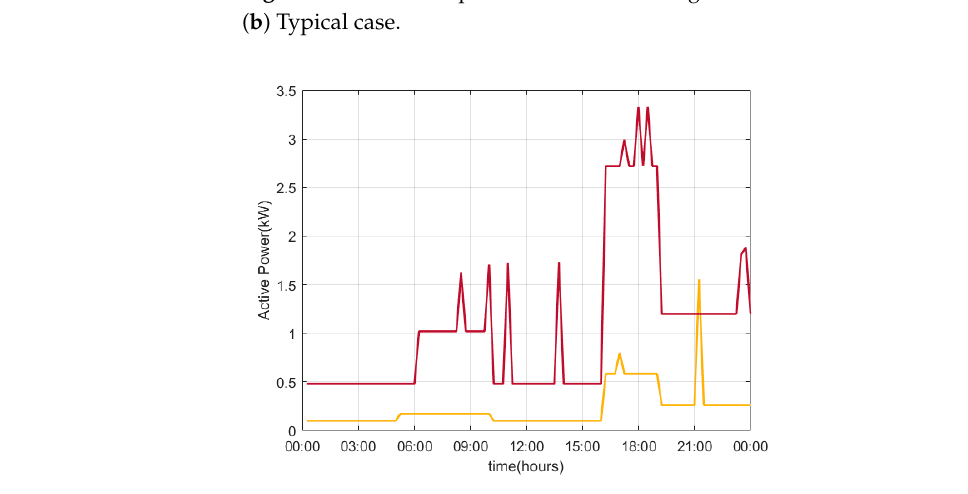
Figure 13. Electrical power consumption of two indicative buildings of the network.